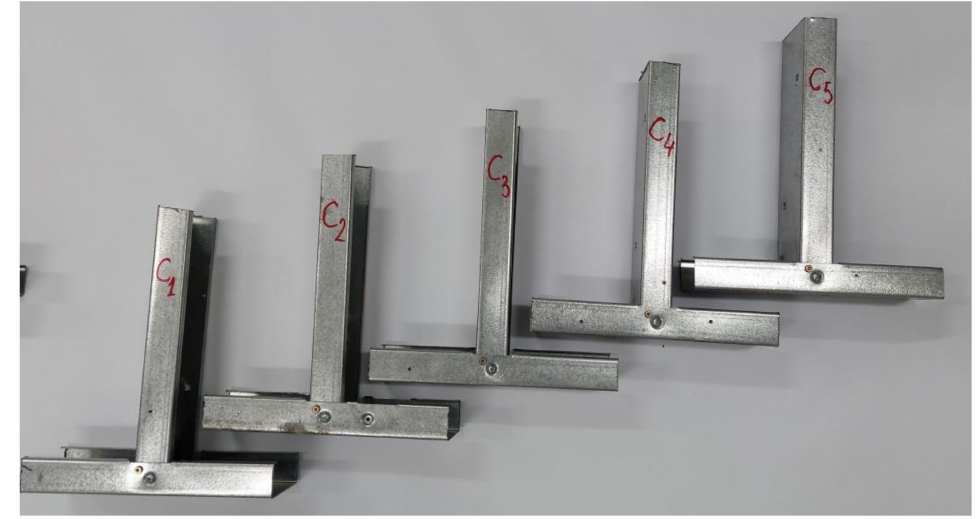
Figure 9. Specimens for C joint.